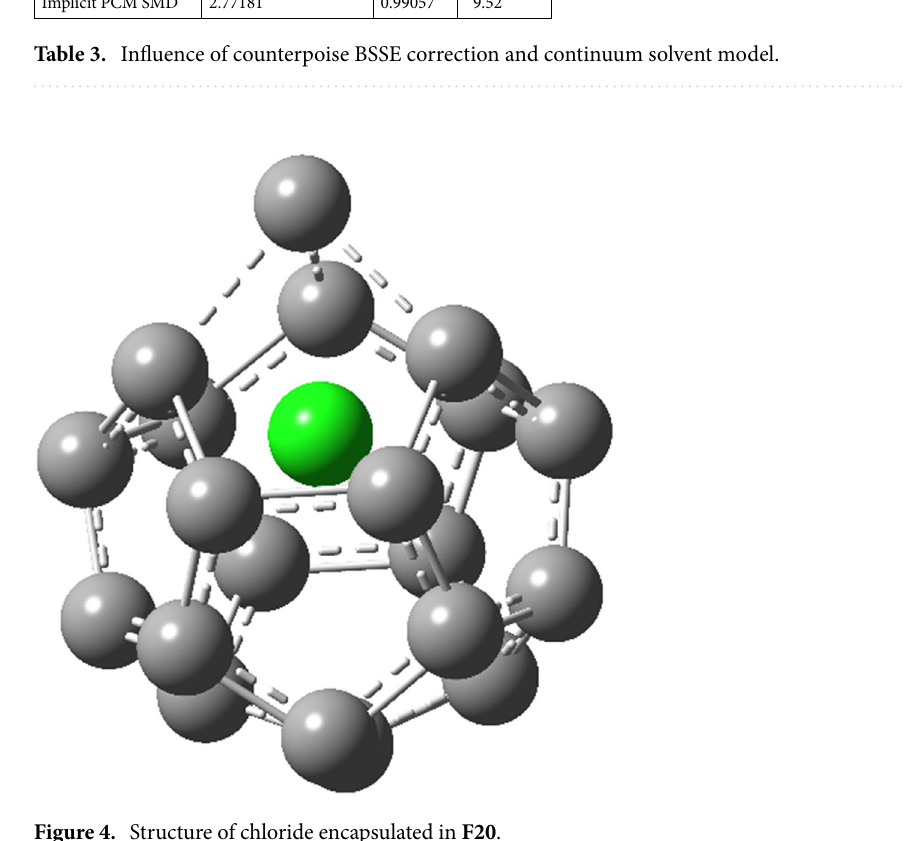
Figure 4. Structure of chloride encapsulated in F20